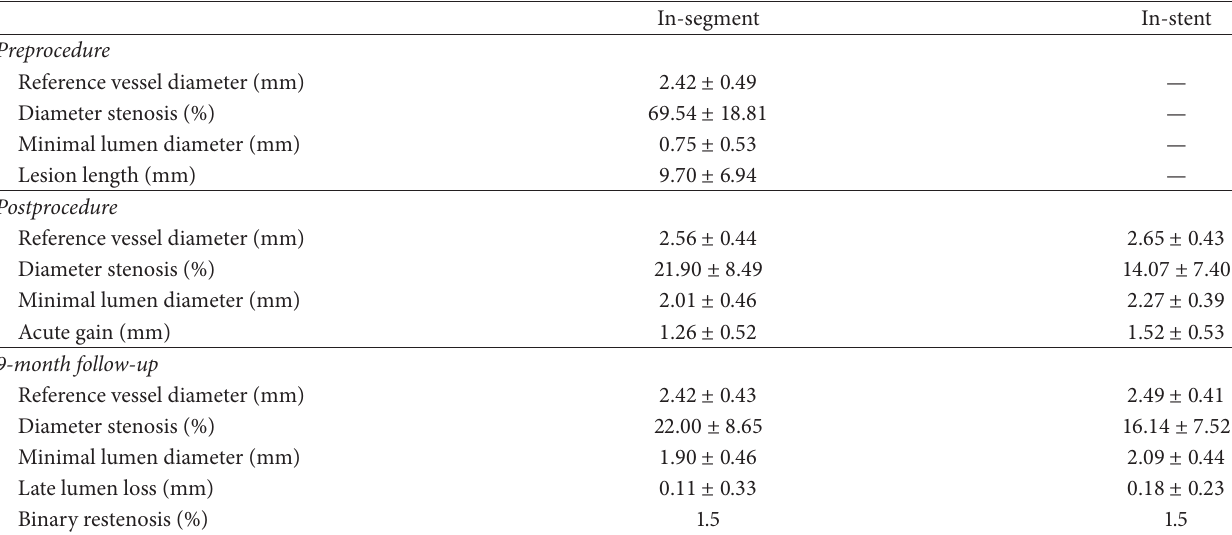
Table 3: Results of quantitative coronary angiography analysis at preprocedure, postprocedure, and 9-month follow-up ( 𝑛 = 61 patients).